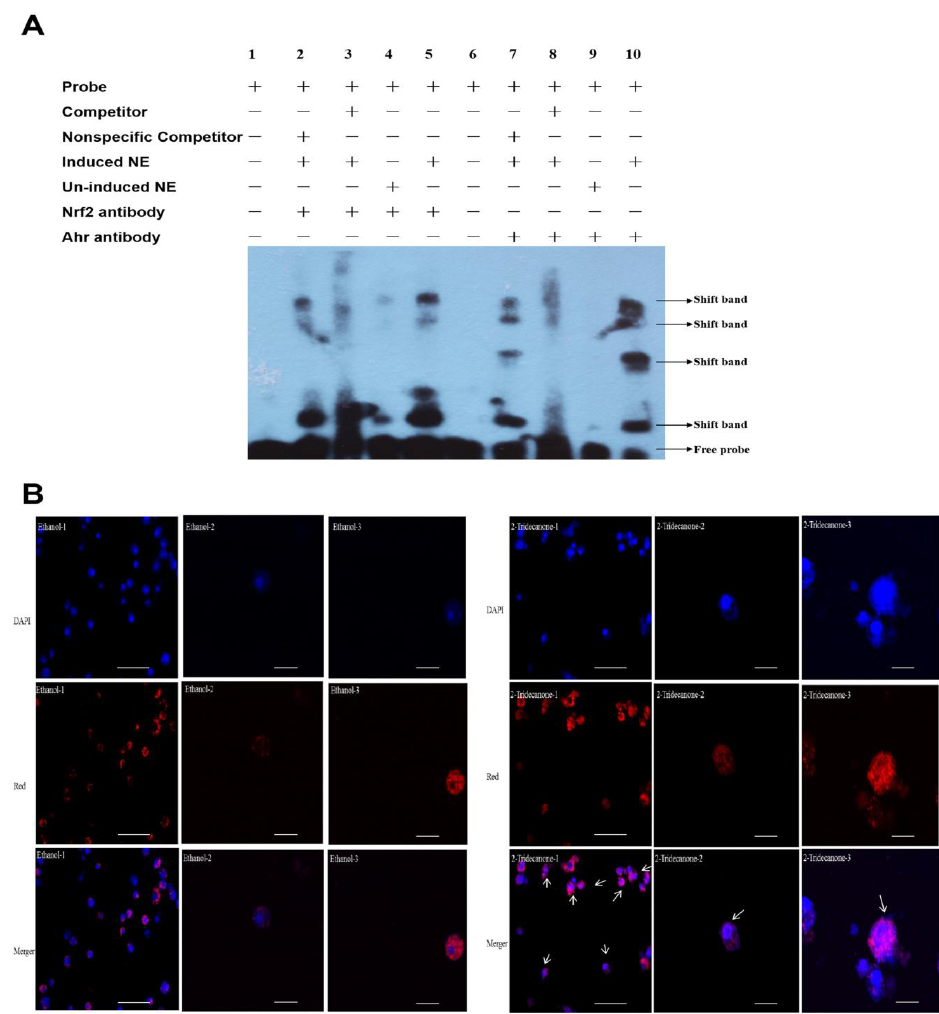
Figure 7. ( A ) sEMSA analysis of the expression of HaNrf2 and HaAhR in nuclear cells after being treated by 2-tridecanone. Nuclear extracts (NE) were prepared from un-induced (un-induced NE) or 2-tridecanone-induced (induced NE) (125 µ M) homologous H. armigera fat body cells. Lane 1, only Nrf2 probe, no nuclear extracts; Lane 2, Nrf2 probe and Nrf2 antibody with nuclear extracts from induced cells, in competition with unrelated nonspecific sequence competitors (200-fold greater than that of the labeled probe); Lane 3, Nrf2 probe and Nrf2 antibody with nuclear extracts from induced cells, in competition with unlabeled probe (concentration 200-fold greater than that of the labeled probe); Lane 4, Nrf2 probe and Nrf2 antibody with nuclear extracts from un-induced cells; Lane 5, Nrf2 probe and Nrf2 antibody with nuclear extracts from 2-tridecanone-induced cells; Lane 6, only AhR probe, no nuclear extracts; Lane 7, AhR probe and AhR antibody with nuclear extracts from 2-tridecanone-induced cells, in competition with unrelated nonspecific sequence competitors (200-fold greater than that of the labeled probe); Lane 8, AhR probe and AhR antibody with nuclear extracts from induced cells, in competition with unlabeled probe (concentration 200-fold greater than that of the labeled probe); Lane 9, AhR probe and AhR antibody with nuclear extracts from un-induced cells; Lane 10, AhR probe and AhR antibody with nuclear extracts from induced cells. ( B ) 2-Tridecanone induced HaNrf2 transfer into the nucleus. DAPI: DAPI staining the nucleus region; Red: using recombinant pAC-v5-Red-Nrf2 plasmid to show the localization of Nrf2; Merger: subcellular localization of Nrf2; 2-tridecanone: the subcellular localization of Nrf2 when the fat body cells were treated with 125 µ M 2-tridecanone, Ethanol: the subcellular localization of Nrf2 when the fat body cells were treated with ethanol. Scale bar in 2-tridecanone-1, Ethanol-1: 100 µ m; Scale bar in Ethanol-2, Ethanol-3, 2-Tridecanone-2, 2-Tridecanone-3: 20 µ